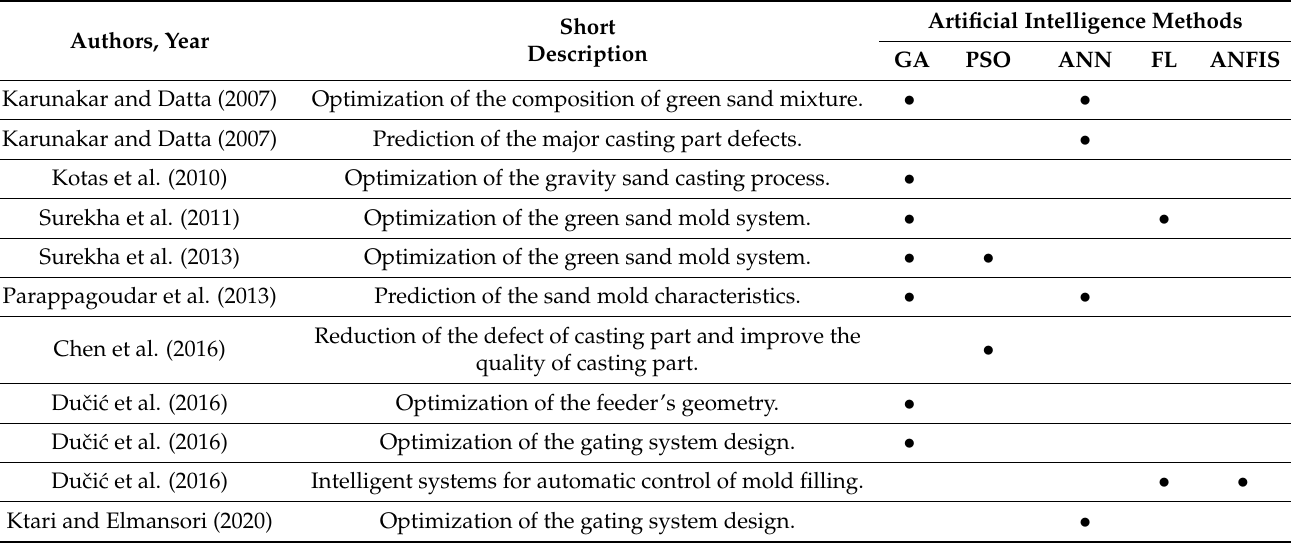
Table 1. Artificial intelligence methods used for the improvement of the sand casting process. Short